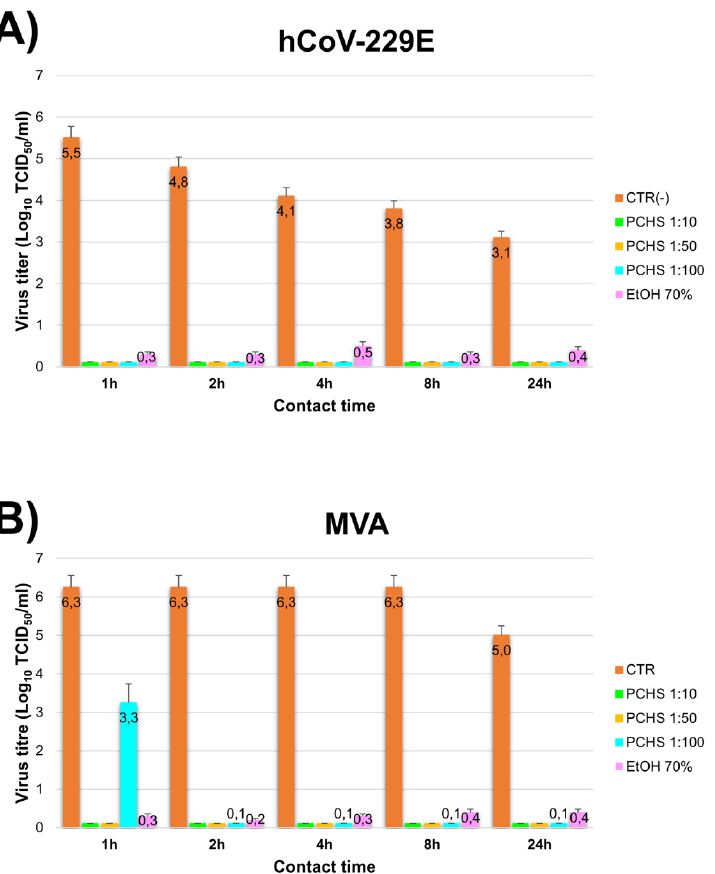
Figure 3. PCHS ability to prevent virus contamination on treated surface. Assays were performed by applying PCHS on surface (dilutions 1:10, 1:50, and 1:100), left to dry, and immediately contaminating treated surfaces with the indicated viruses. After 1, 2, 4, 8, and 24 h, samples were collected and the residual virus titre was evaluated by Spearman-Karber method. As control, 70% EtOH was used; results are expressed as Log 10 TCID 50 / mL , and represent the mean ± SD values of duplicate samples from three independent assays. ( A ) hCoV-229E results. ( B ) MVA results. Lastly, the long-term ability of PCHS to prevent virus contamination was assessed on surfaces. PCHS (diluted 1:10, 1:50, and 1:100) was applied on surfaces and left to dry, then virus inocula were added to treated surfaces after 1, 2, 4, 8, and 24 h. Viruses were left in place for 2 h and then collected to measure residual virus titre (Figure 4).